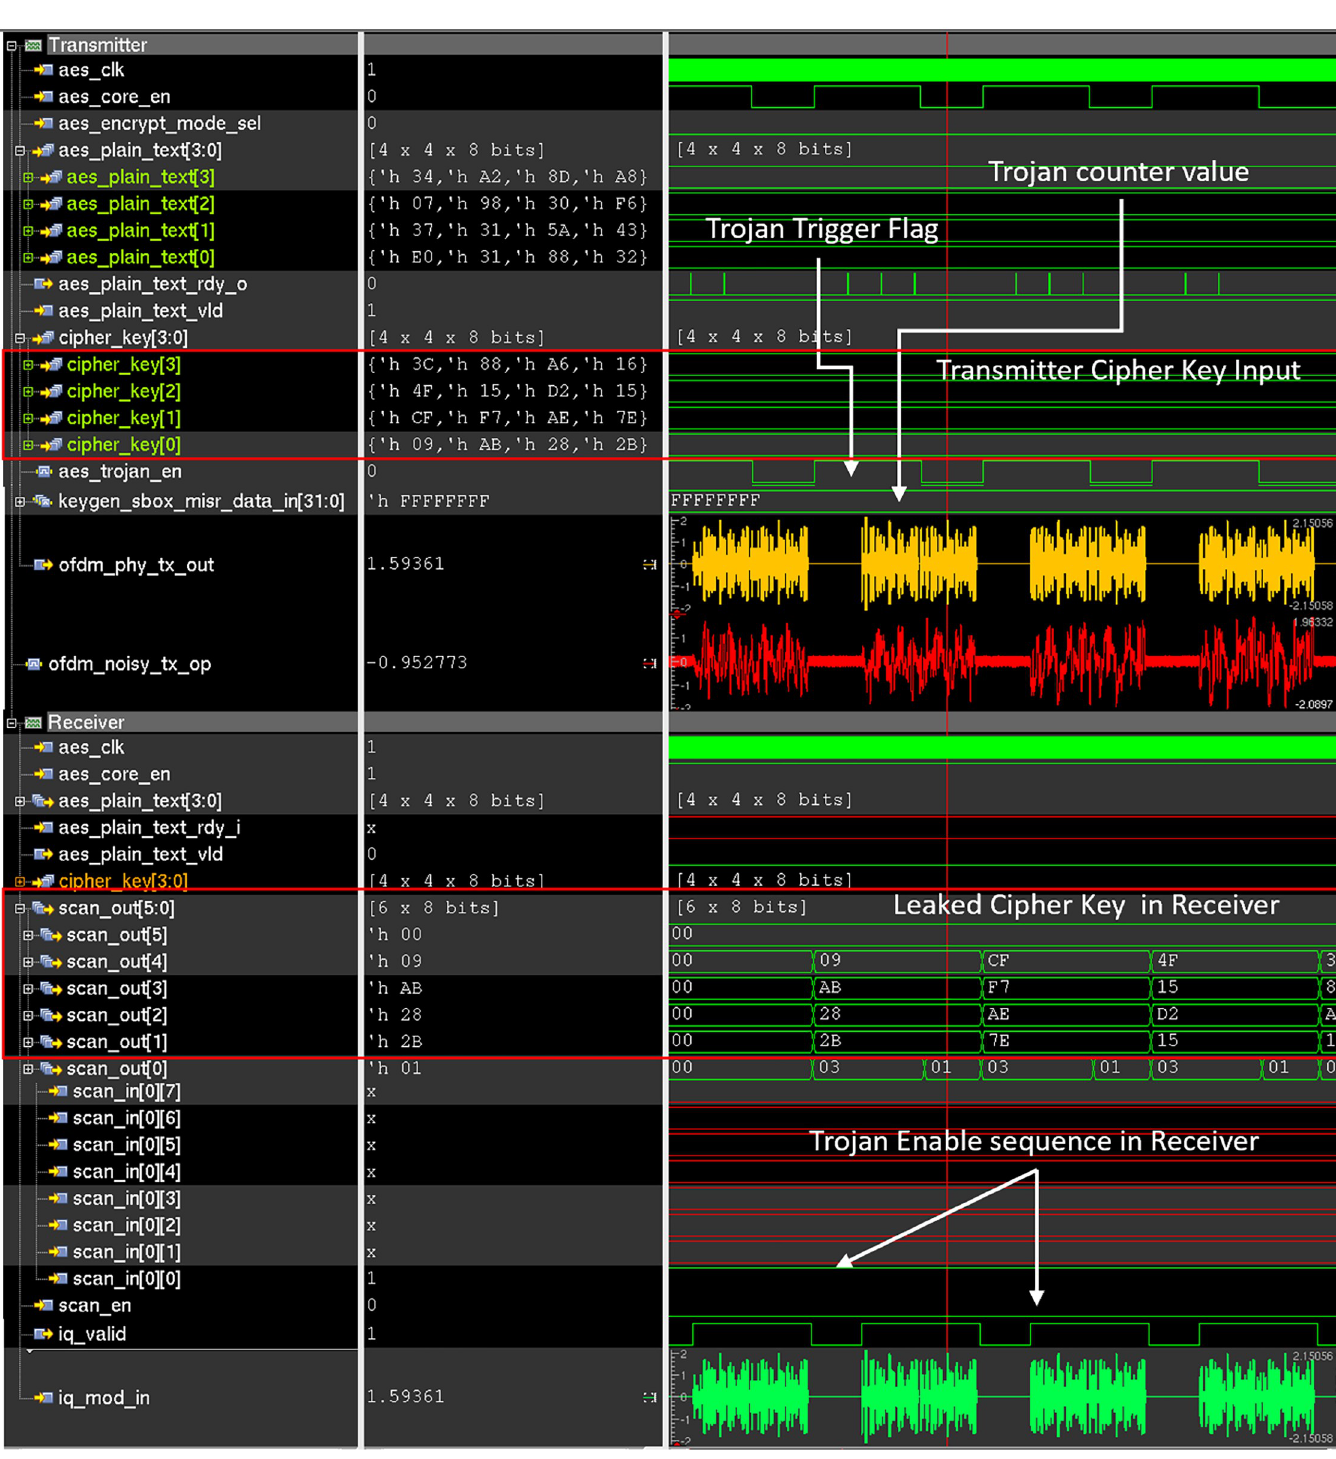
PLOS ONE | https://doi.org/10.1371/journal.pone.0254903 July 29,